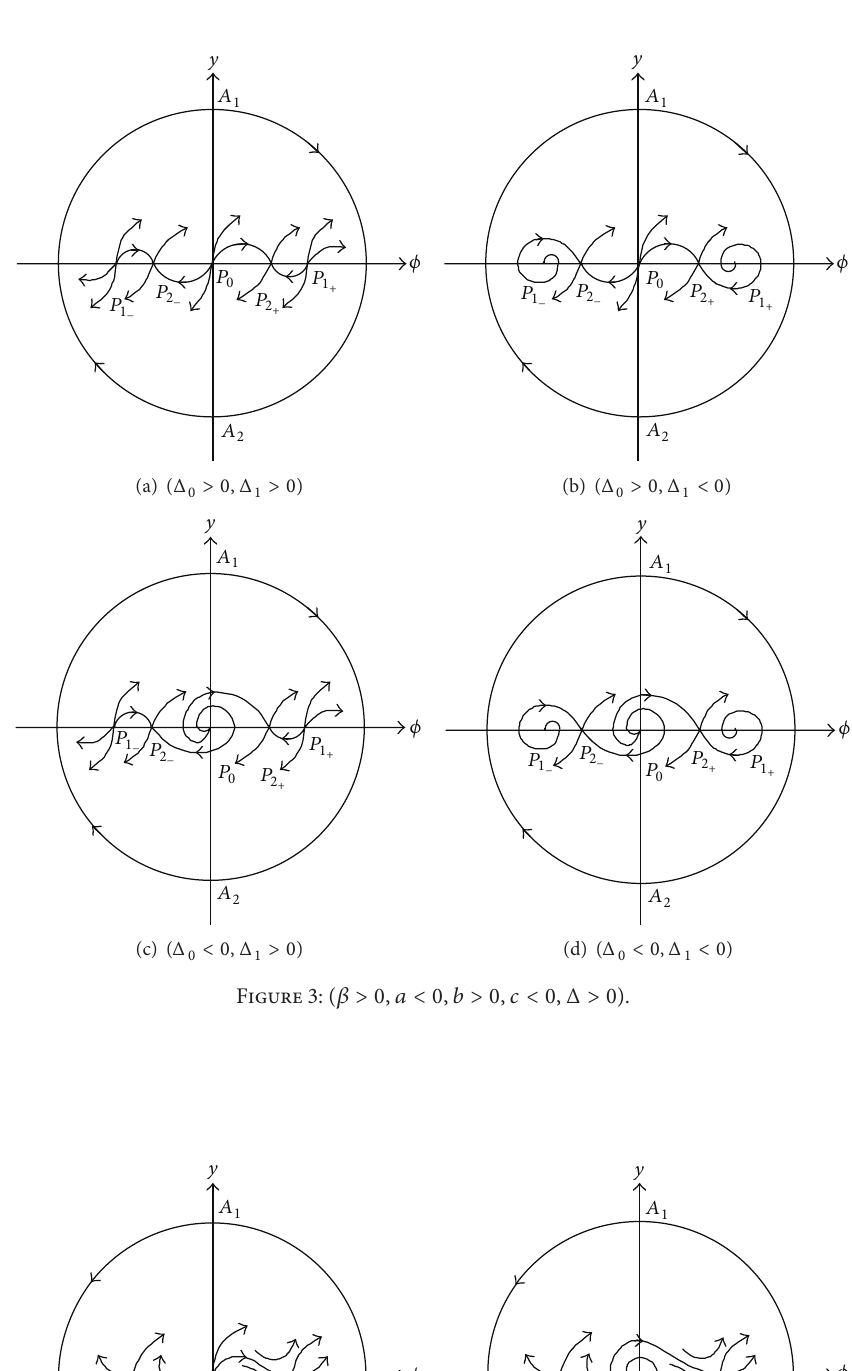
Figure 4: ( 𝛽 > 0 , 𝑎 < 0 , 𝑏 > 0 , 𝑐 < 0 , Δ = 0